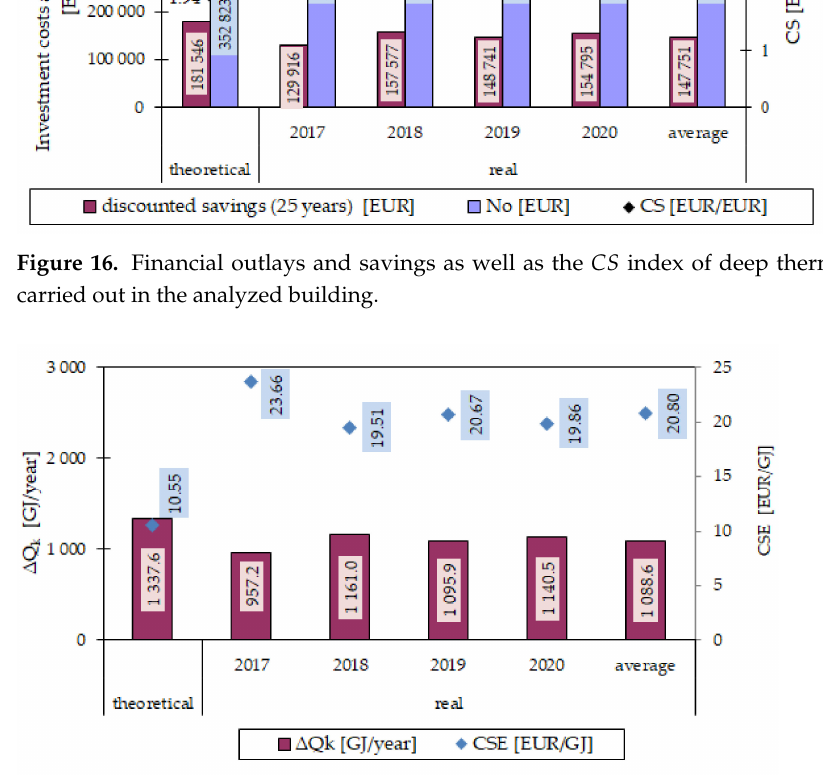
Figure 17. Annual energy savings and the CSE index of a thermomodernization investment in the analyzed